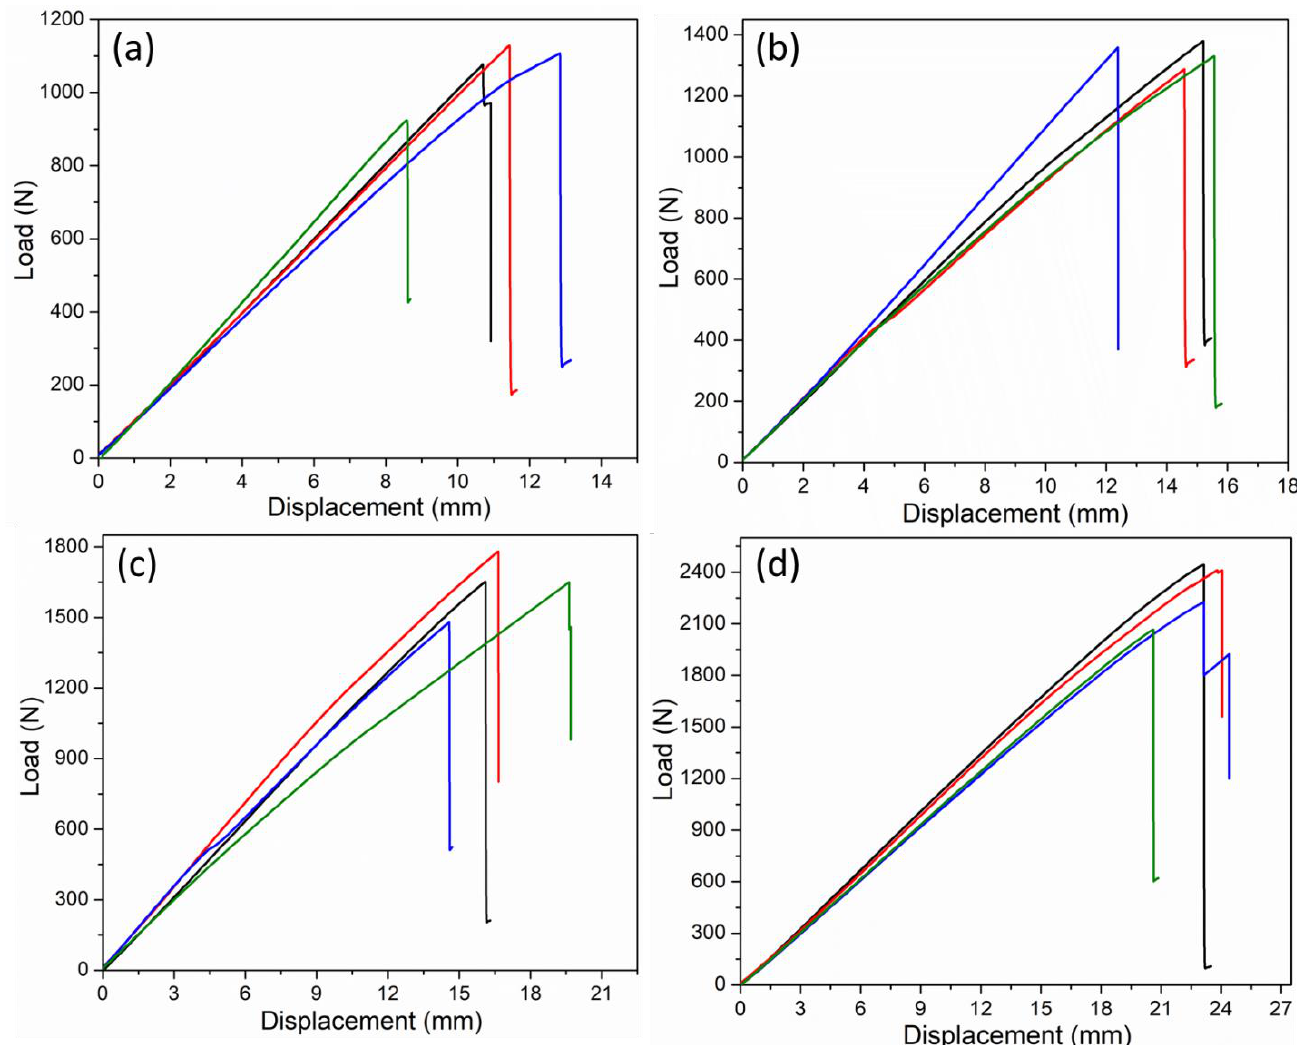
Figure 8. Flexural load vs. displacement curves for ( a ) Type A specimens repaired at room temperature, ( b ) Type B specimens repaired at room temperature, ( c ) Type A specimens repaired at 210 °C, and ( d ) Type B specimens repaired at 210 °C.